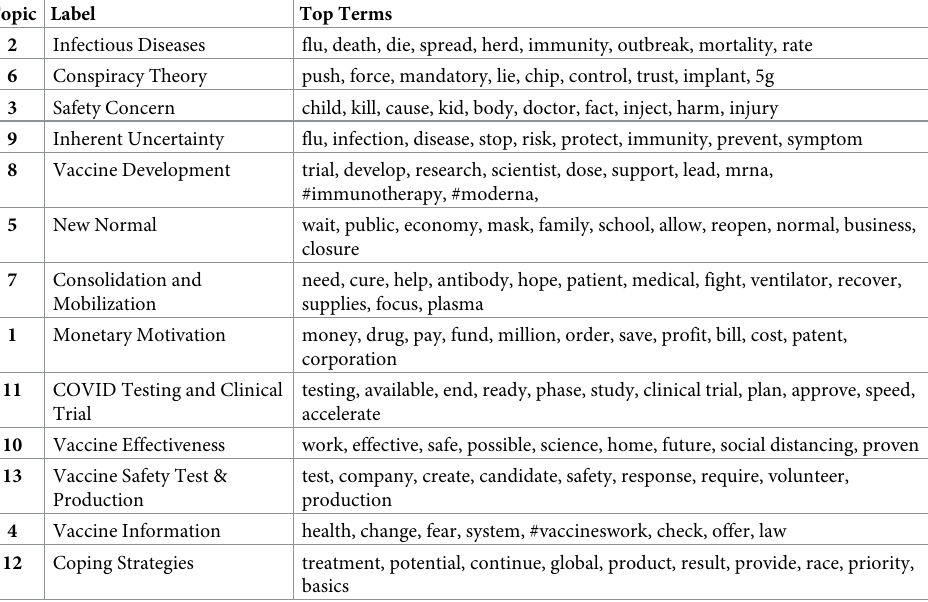
Table 1. The 13-topic structure that characterizes the U.S. COVID-19 vaccine